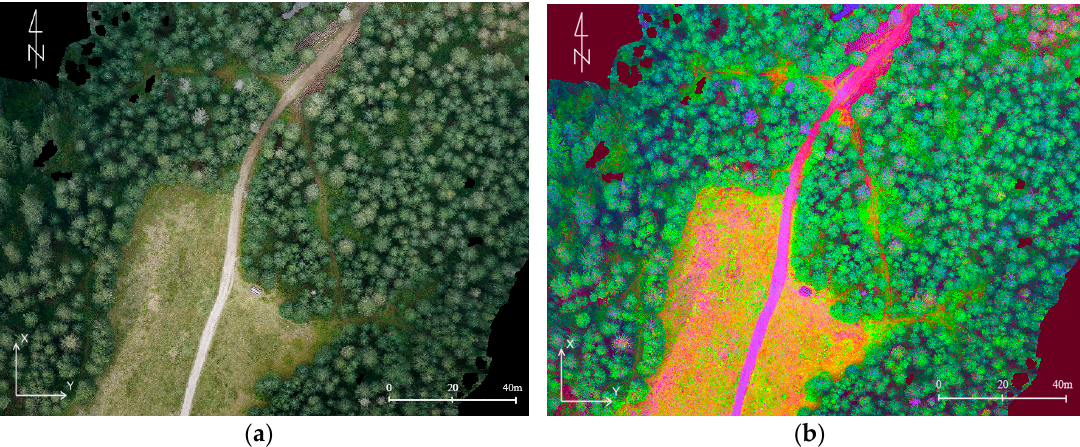
Figure 21. ( a ) A fragment of the orthophotomap with the tourist trail between Dolina Chochołowska and Trzydniowia ń ski Wierch; and ( b ) decorrelation stretching conducted on the basis of the analysis of the main components (source: authors’ own study).